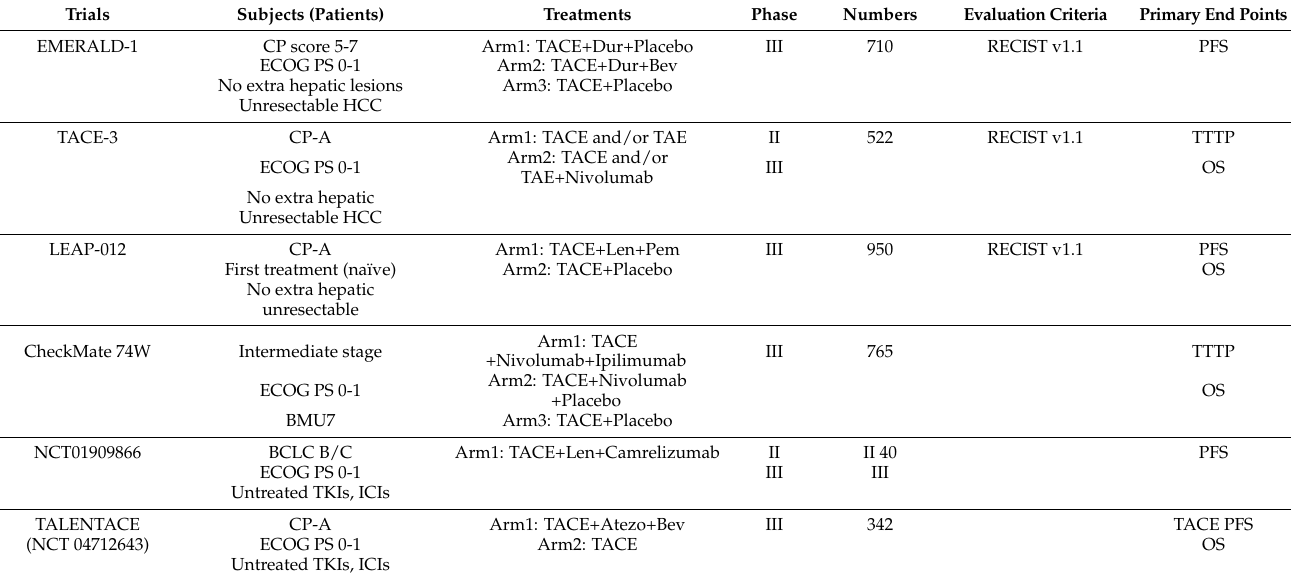
Table 1. Ongoing trials on combination therapy with transarterial chemoembolization (TACE) and immune-checkpoint